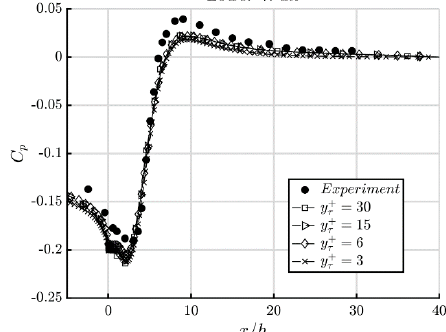
Figure 3. Comparison ofpressure coefficient ( C p ) and expe– rimental values.Filled circles [50] and simulated – square – y t + = 30, triangle – y t+ = 15, diamond – y t+ = 6, and x – y t+ = 3.